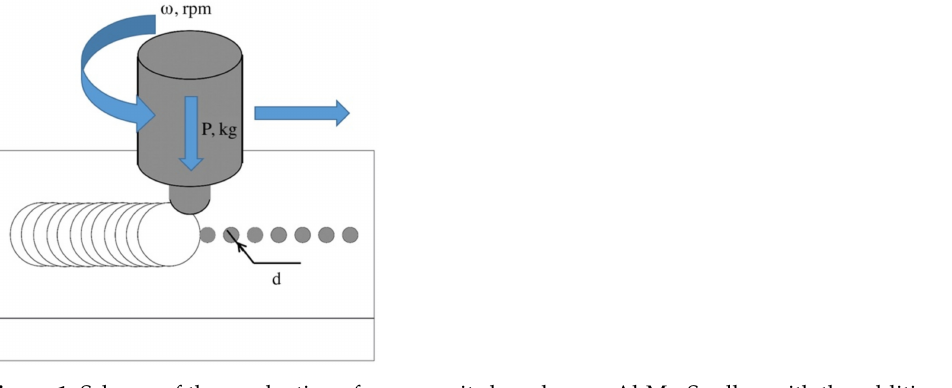
Figure 1. Scheme of the production of a composite based on an Al-Mg-Sc alloy with the addition of Mo powder via friction stir processing. ω —tool rotation speed; P—tool loading force; d—diameter of a hole for the powder addition.